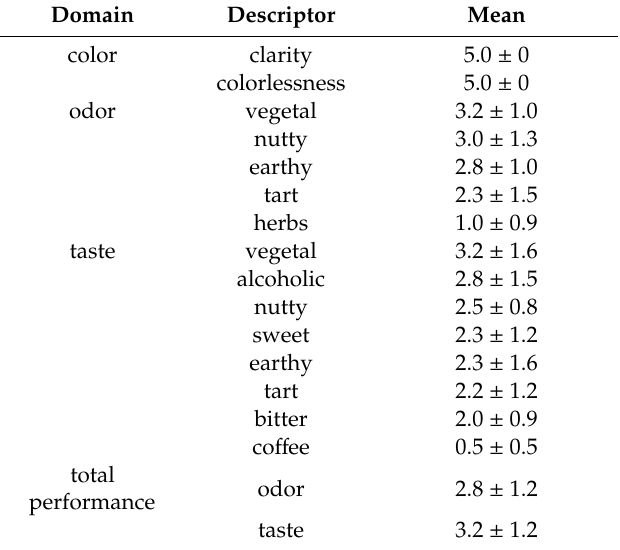
Table 1. Co ff ee Cherry Spirit-Specific Sensory Descriptor List (SSDL) with Hedonic Scale Evaluation. Means Given with Standard